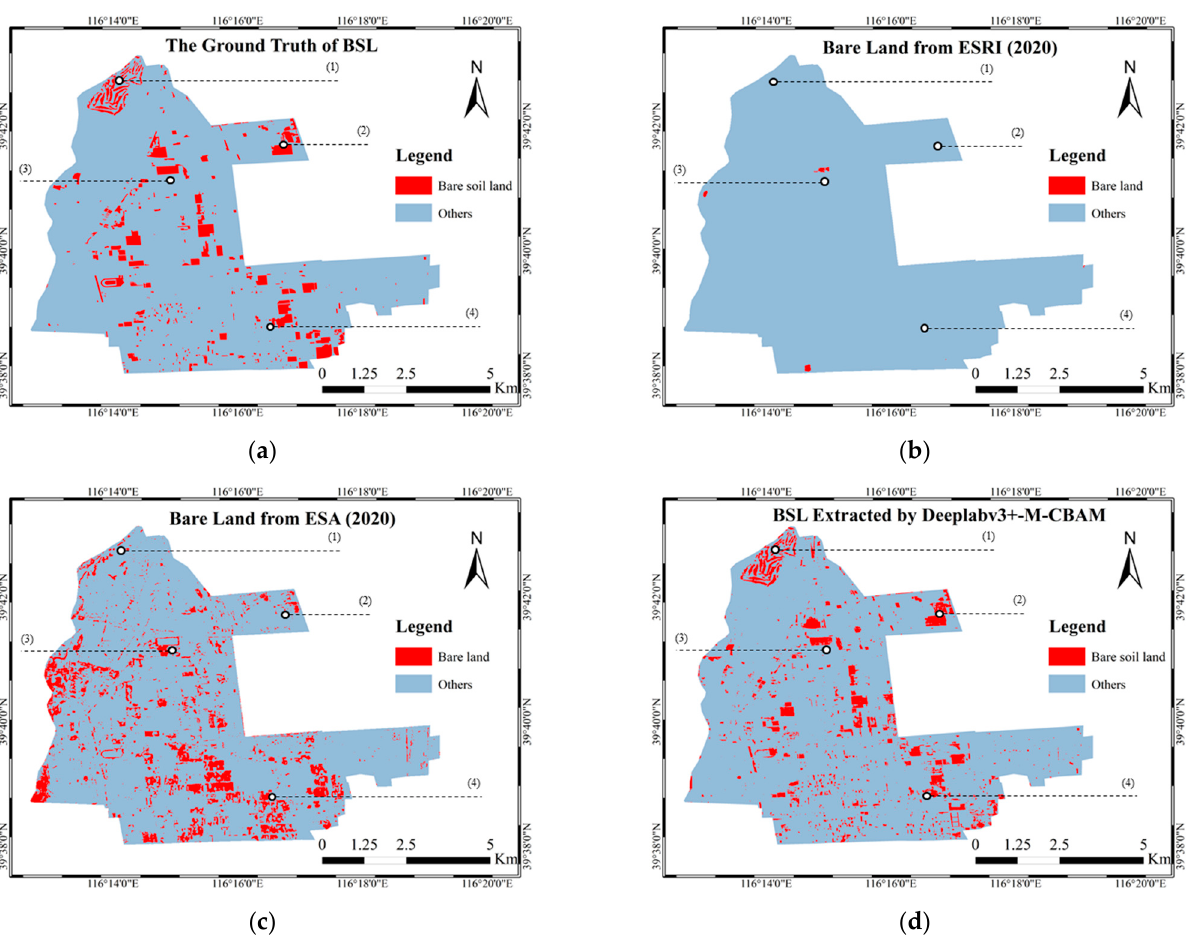
Figure 16. BSL-related mapping results for the different LULC products: The coordinate system of the maps is